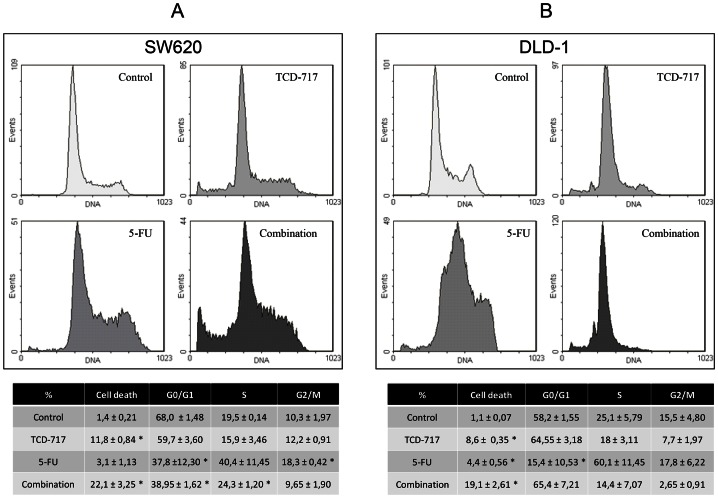
Cell cycle distribution in DLD-1 and SW620 from TCD-717 and 5-FU treatment, alone or in combination.2,5×105 DLD-1 and SW620 cell lines were seeded in 6 well plates and incubated for 24 h with TCD-717 followed by 5-FU for 24 h alone or in combination. Combination of the two drugs increased cell death compared to the two drugs alone. Tables under the graphics indicate the percentage of the different phases of cell cycle when we treat with TCD-717 and 5-FU alone or in combination. *p<0.05 compared the different cell cycle phases vs. control.